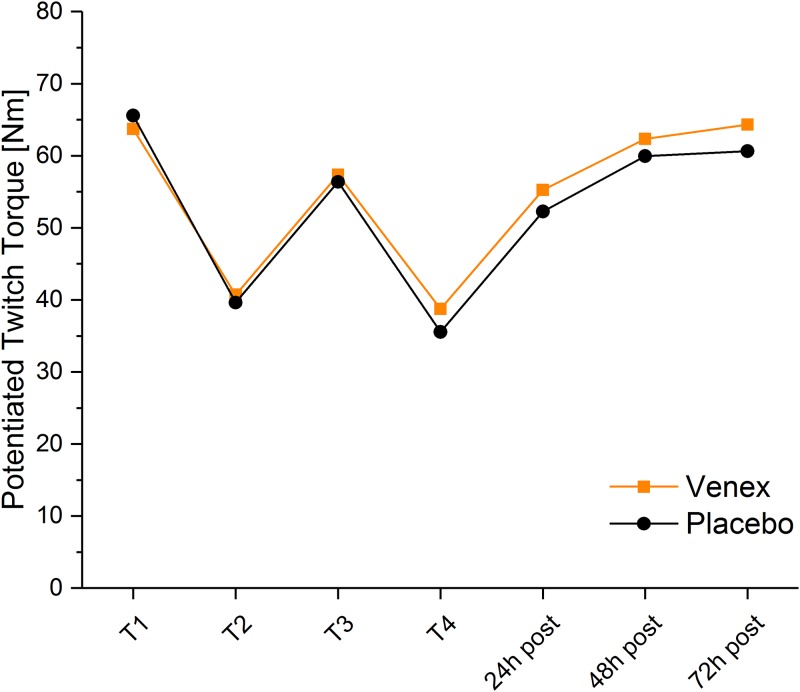
Potentiated twitch torque for both treatments over time.Data represent the mean ± 95% confidence intervals of the potentiated twitch torques.